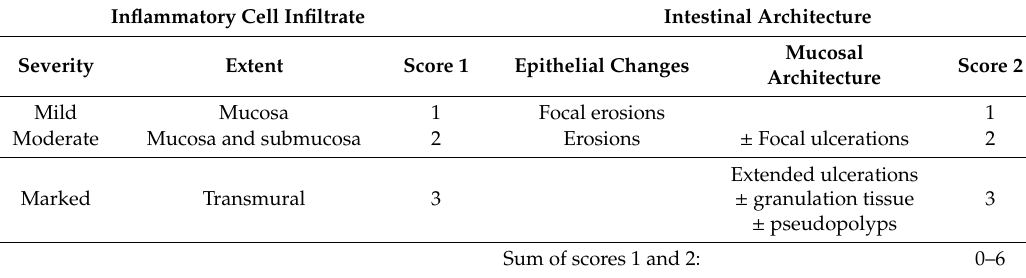
Table 3. Scoring of histomorphology for chemically-induced colonic